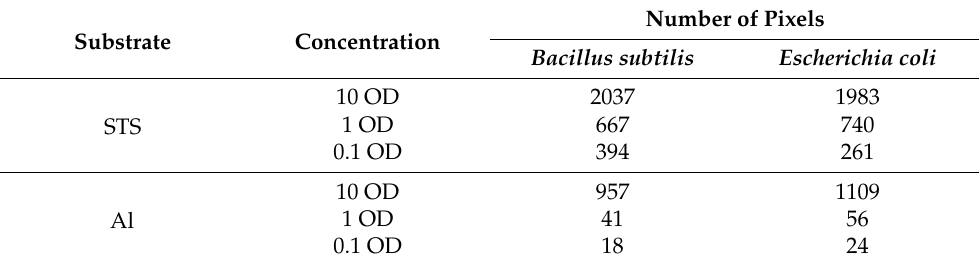
Table 2. The number of pixels of each class from the two substrates that were used for modelling. Number of Pixels Substrate Concentration Bacillus subtilis Escherichia coli 10 OD 2037 1983 1 OD STS